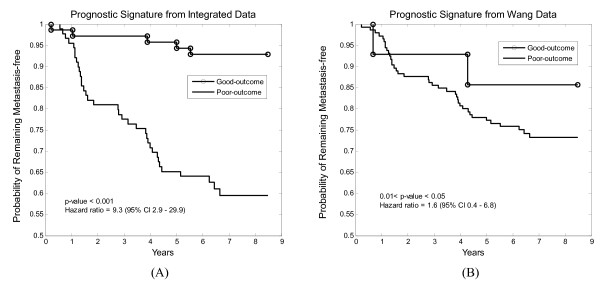
The Kaplan-Meier analysis. Kaplan-Meier analysis of the probability of remaining free of distant metastases among 159 Pawitan patients between the good-outcome group and the poor-outcome group. The LRT is based on the integrated data in (A) and the single, Wang data set in (B). CI denotes confidence interval and the p-value is calculated by the log-rank test.